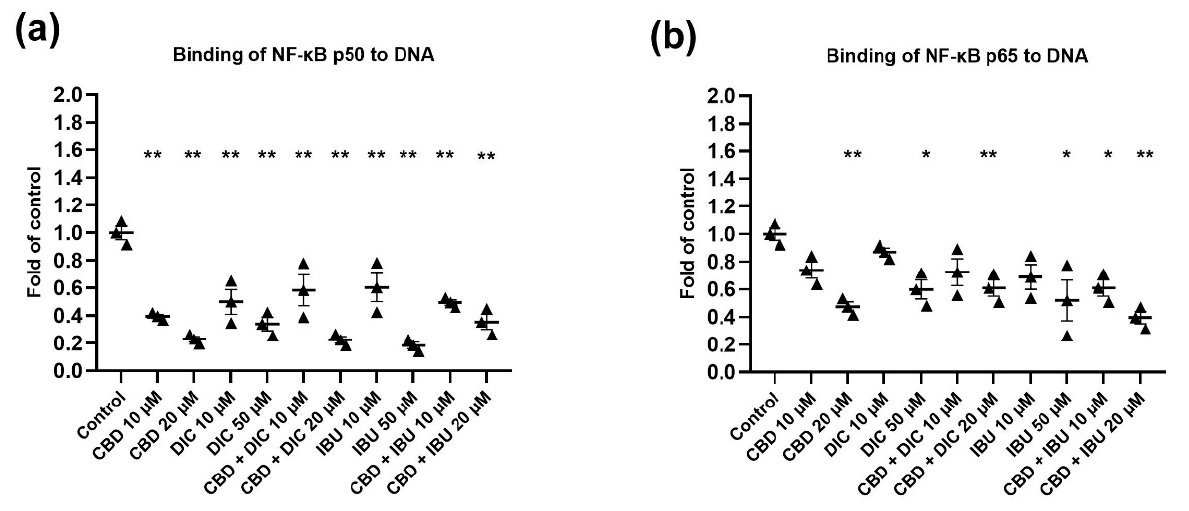
Figure 6. The effect of CBD and its combinations with DIC and IBU on the level of NF- κ B p50 ( a ) and p65 ( b ) binding to DNA. The values (mean ± SEM) were calculated as a relative change in the protein level compared to the control cells from three separate experiments. Mean values significantly different from the control group are indicated with * p < 0.05 and ** p < 0.01.